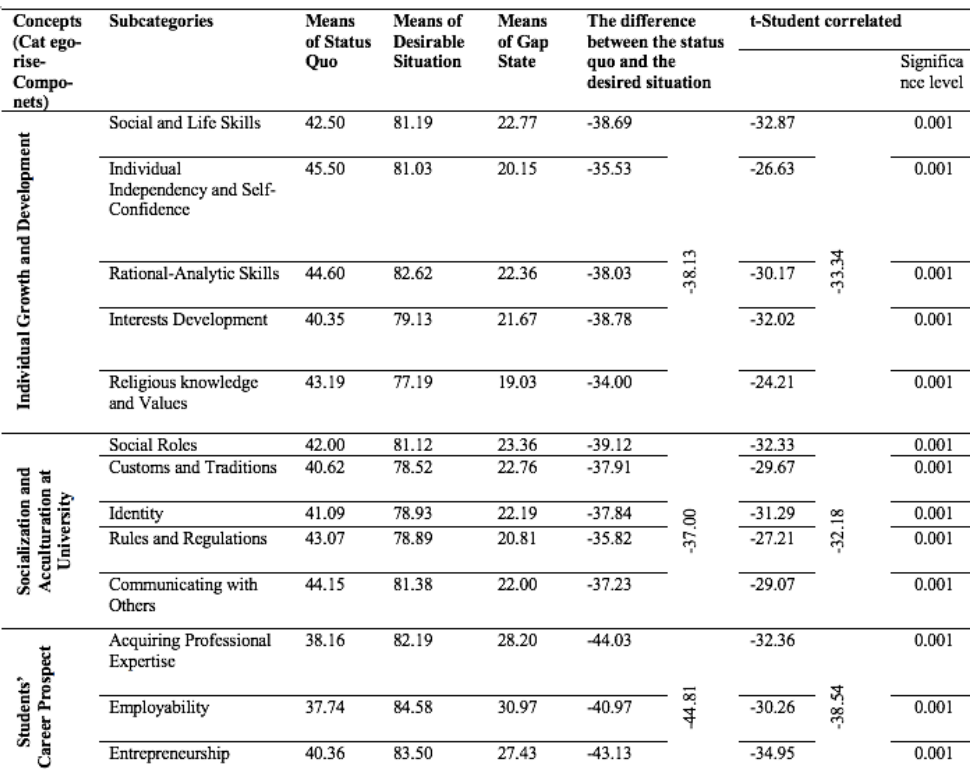
Table 4. The mean of the status quo, the desirable status, and the gap status of the components, and the results of the